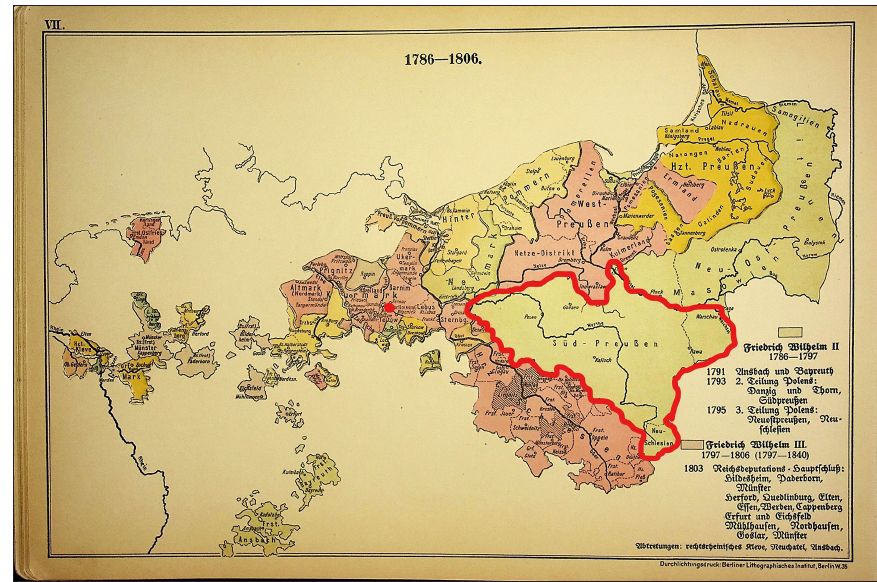
Figure 1: Prussian 1786-1806. South Prussia’s original border (1793) is outlined in red. To the left of the province, a red dot marks the location of